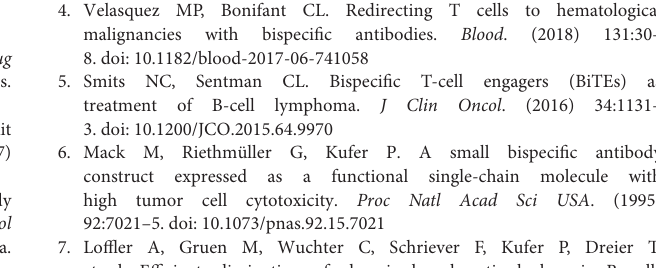
FIGURE 6 | In vivo activity of TfR-BiTE in NCG mice. NCG mice were subcutaneously injected with 1 × 10 6 HepG2 cells on day 0. At day 7, mice were i.v. injected with 10 × 10 6 PBMCs from healthy human donors. Antibodies (20 µ g/mouse) or PBS were administered intravenously 6h after the transfer of PBMCs. Antibodies were given every day for 7 consecutive days. Tumor volume was measured by a digital caliper. (A) Schematic map for the development of xenograft mouse model. (B) Tumor growth curve of individual mice ( n = 4 or 5). Each represents a single mouse. (C) The mean tumor volume at the end of the experiment (day 46). (D) Images of the tumors harvested from the mice at the end of the experiment. (E) Human CD3 + cell infiltration in tumor tissues. (F) The body weight curves of mice for each group. (G) TfR-BiTE elicited no toxicities to liver and kidney. Tissues were collected and stained with haematoxylin and eosin. Scale bar indicates 50 µ m. Abbreviations: mAb Mix, TfR mAb, and CD3 mAb mixture. * p < 0.05; ** p <